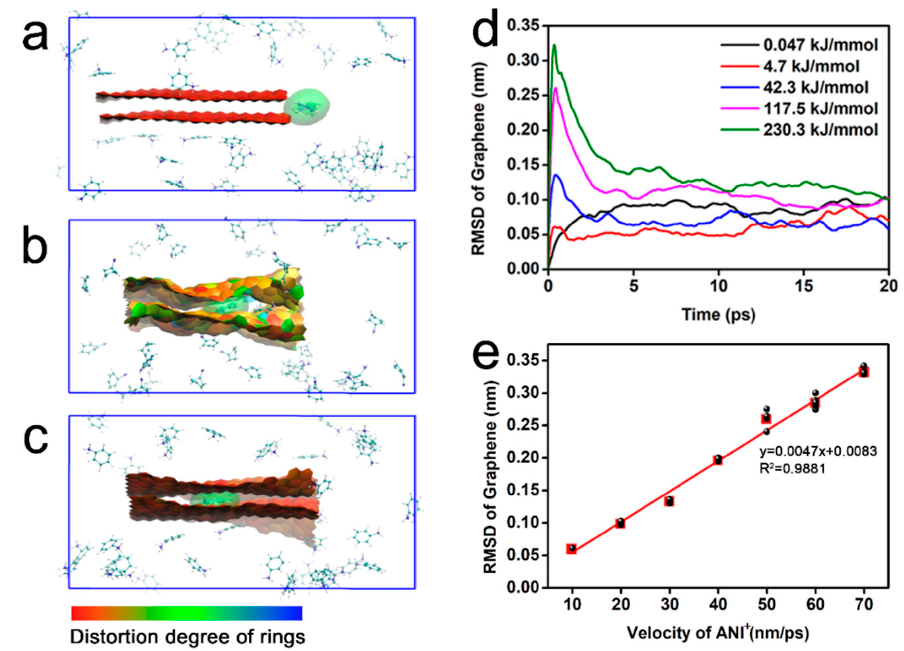
Figure 6. MD simulations of ANI + intercalating into the interlayer of bilayer graphene. ( a – c ) Snap- shots of the aniline cations intercalating into the interlayer of bilayer graphene with a simulated time of ( a ) 0 ps, ( b ) 0.3 ps, and ( c ) 3 ps. Water molecules are hidden in the snapshots. The graphene is presented using paper chain model to exhibit its distortion. The intercalating aniline cations are presented using a van der Waals surface model (green). ( d ) RMSD curves of bilayer graphene intercalated by aniline cations with different initial kinetic energy; ( e ) relationships between the maximal RMSD values and the initial kinetic of aniline cations.